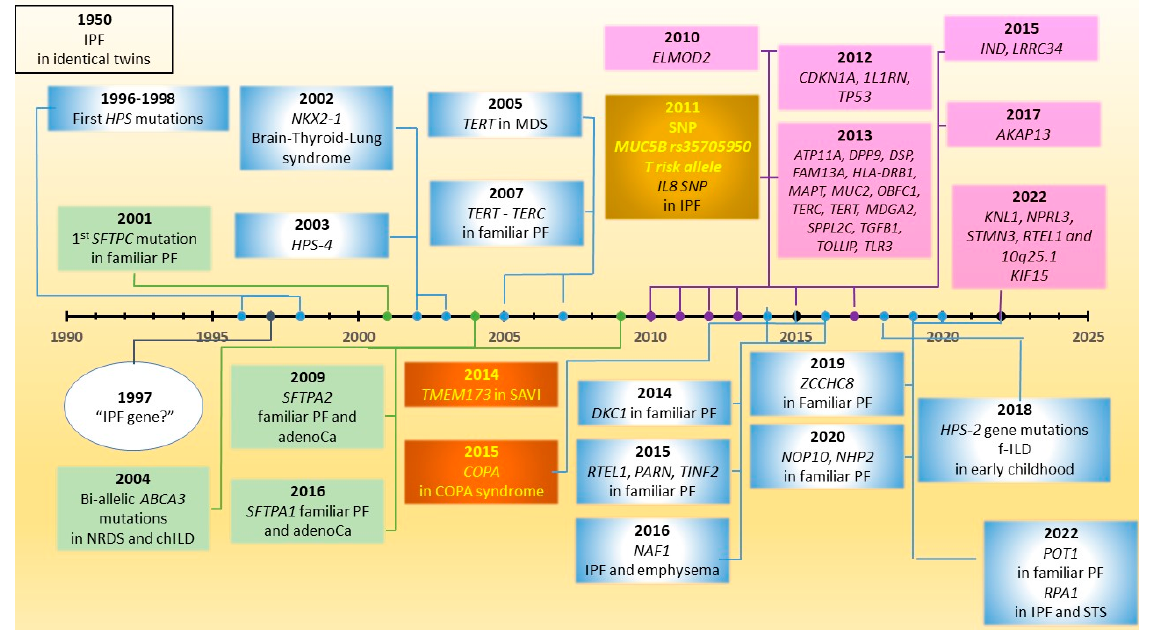
Figure 2. Discoveries in IPF genetics: 1950: IPF is reported in identical twin sisters; 1996–1998: First mutations in Hermansky–Pudlak syndrome ( HPS) genes; 1997: Is there is fibrosis gene in pulmonary fibrosis? 2001: First SFTPC mutation in familiar IP; 2002: NKX2-1 mutations in brain-thyroid-lung syndrome; 2003: HPS-4 mutations; 2004: Bi-allelic ABCA3 mutations in NRD syndrome and chILD; 2005: Mutations in TERT in patients with bone-marrow failure; 2007: TERT and TERC mutations in familiar IP; 2009: SFTPA2 mutations FIP and adenocarcinoma families, 2010: ELMOD2 SNP polymorphism in IPF; 2011: A common SNP in the promoter region of the gene MUC5B : the strongest polygenic risk factor for sporadic IPF and familiar IP; 2011: IL8 SNP polymorphism in IPF; 2012: CDKN1A, 1L1RN, TP53 SNP polymorphisms in IPF; 2013: ATP11A, DPP9, DSP, FAM13A, HLA-DRB1, MAPT, MUC2, OBFC1, TERC, TERT, MDGA2, SPPL2C, TGFB1, TOLLIP, TLR3 SNP polymorphisms in IPF; 2014: DKC1 mutation in familiar IP; 2014: TMEM173 mutations in SAVI, 2015: RTEL1 , PARN and TINF2 mutations in familiar IP; 2015: COPA mutations in COPA syndrome; 2015: IND, LRRC34 SNP polymorphisms in IPF; 2016 SFTPA1 mutations in FIP and/or adenocarcinoma families; 2016: NAF1 mutations in pulmonary fibrosis-emphysema; 2017: AKAP13 SNP polymorphism in IPF; 2018: HPS-2 gene mutations: fibrosing lung disease early in childhood; 2019: ZCCHC8 mutations in FIP; 2020: NOP10 and NHP2 mutations in FIP; 2022: POT1 mutation in FIP; 2022: KNL1, NPRL3, STMN3, RTEL1 , and an intergenic variant in 10q25.1 in IPF; 2022: KIF15 mutations in IPF; 2022: RPA1 mutations in pulmonary fibrosis and